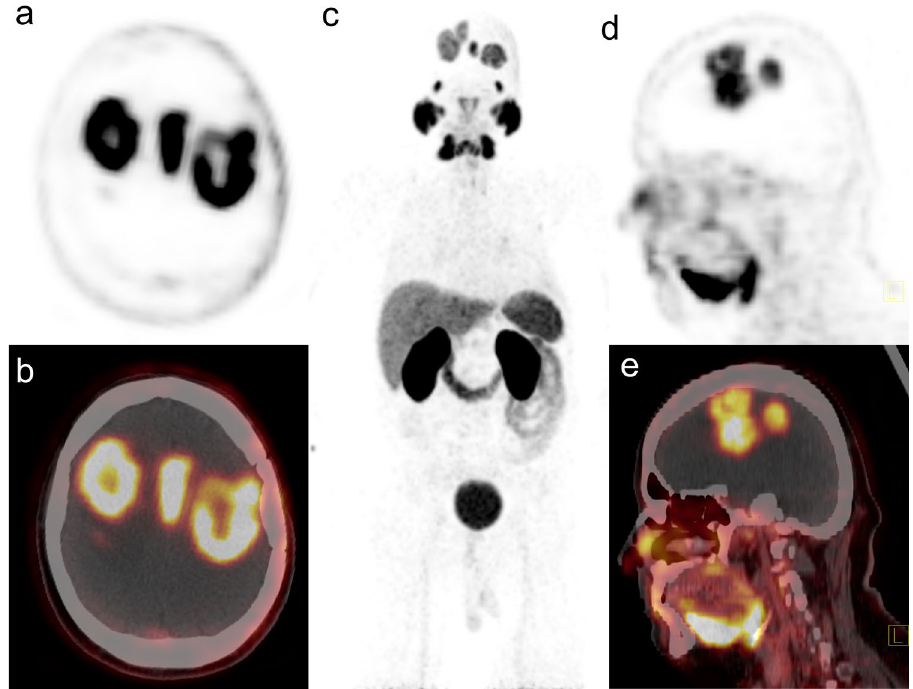
Figure 3. Male, 54 years, with a recurrent multiple high-grade glioma. MR performed 4 months after treatment initiation revealed a mass around the surgical cavity in the left temporo-parietal lobe and multifocal tumors in the right frontal, right parietal lobe and parasagittal area. [ 68 Ga]Ga-PSMA-11 PET/CT showed high accumulation in the all tumors with the highest SUV max 15.6, SUV mean 7.5, TBR 156 and TLR 2.8 ( a —PET transverse image, b —fused PET/CT transverse image, c —maximal intensity projection, d —PET sagittal image, e —fused PET/CT sagittal